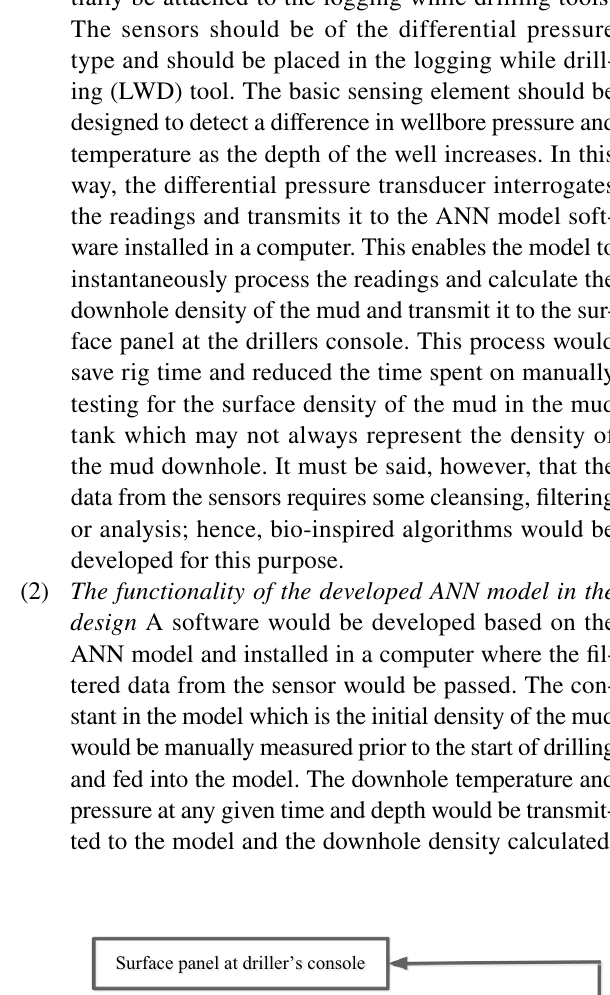
Fig. 6 Drilling process design with the ANN model incorpo-